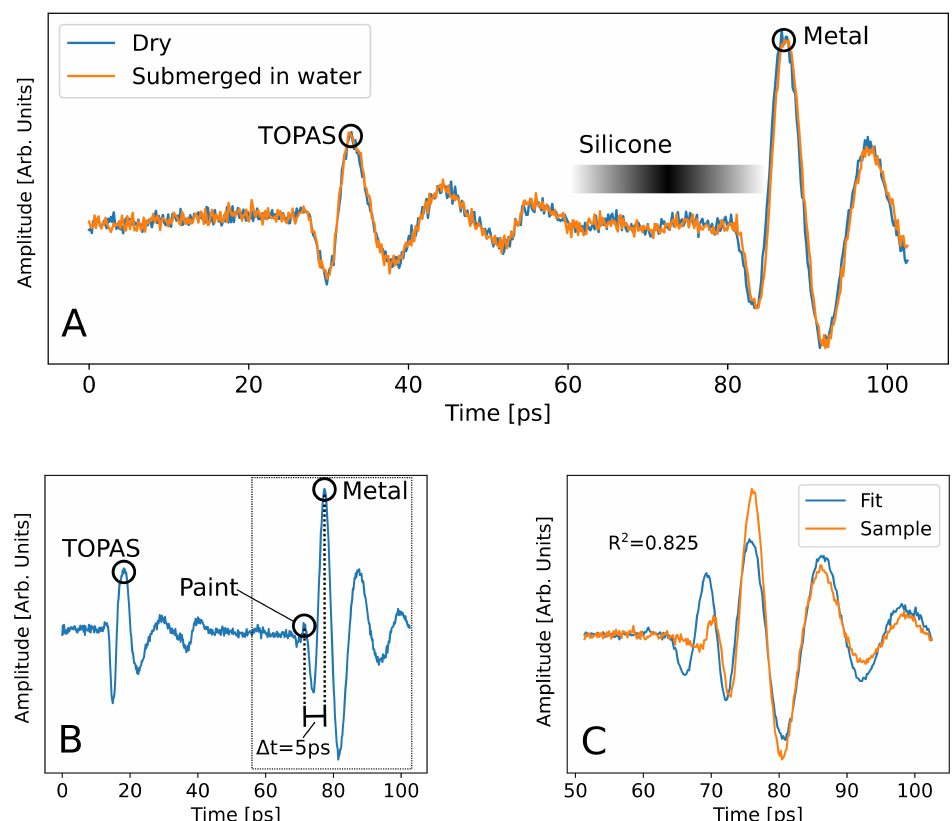
Figure 5. ( A ) Measurements on a metal surface through the developed contact patch in dry and submerged conditions. The fading bar shows the expected location of the silicone reflection. ( B ) Mea- surement of the sample through the developed contact patch underwater. Notice that there is no reflection at the plastic/silicone interface. ( C ) Fit on the measurement from ( B ) when only considering the signal from 50ps ( R 2 score of